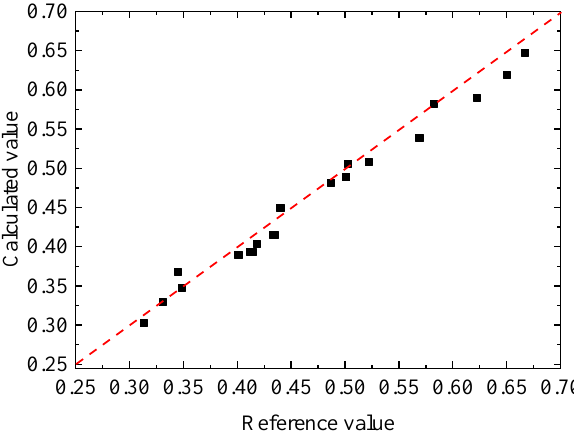
Figure 4. Validation of least square support vector machine (LS-SVM) model.